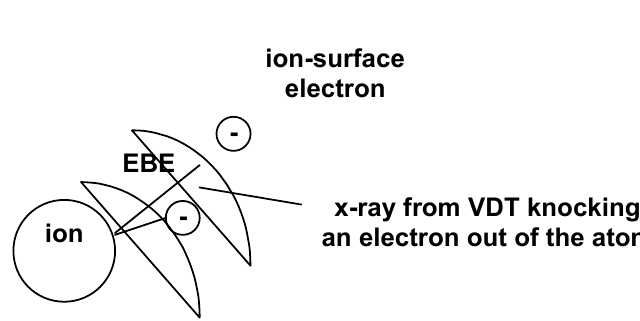
Figure 2: the typical positions of electrons in an